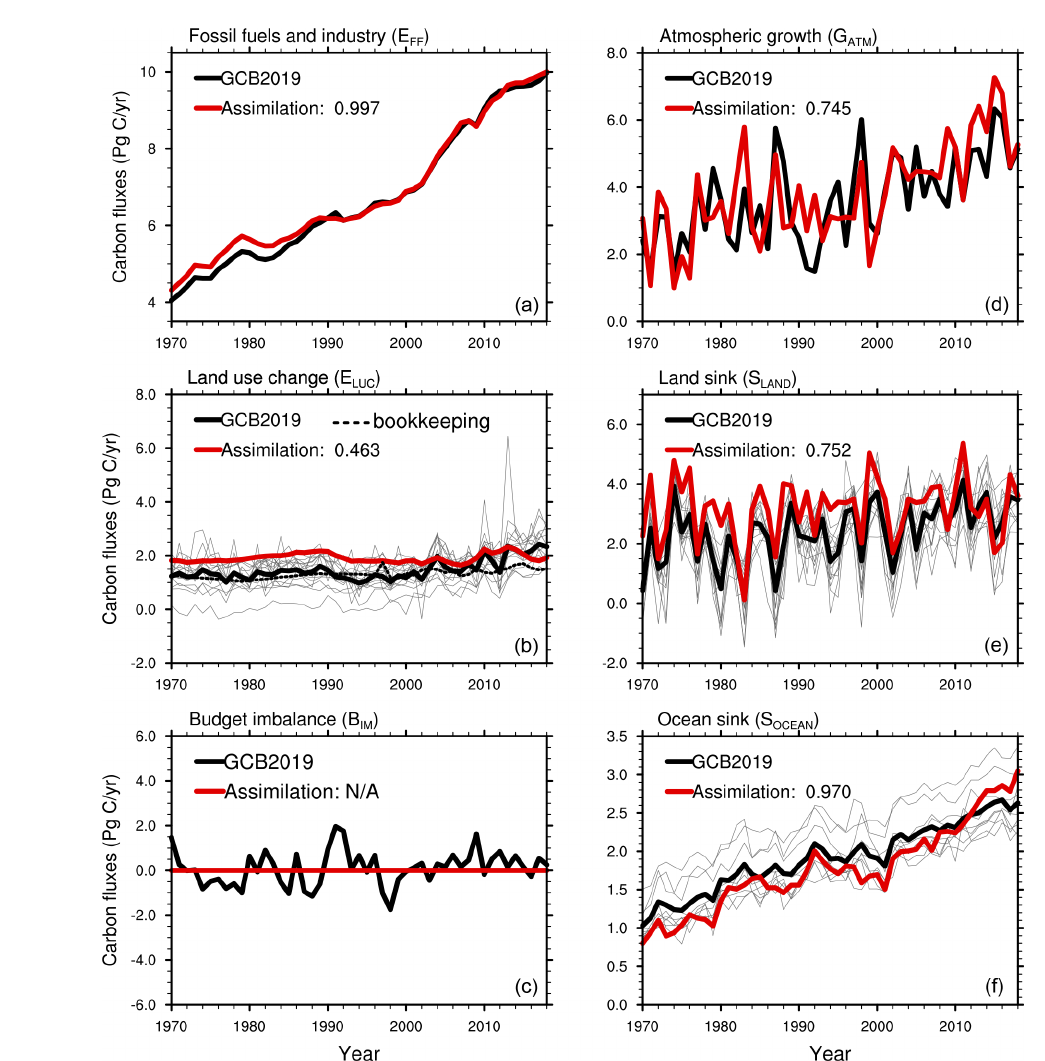
Figure 2. Time series of (a) fossil fuel and industry CO 2 emissions ( E FF ), (b) emissions from land use change ( E LUC ), (c) the budget imbalance ( B IM ) that is not accounted for by the other terms, (d) atmospheric carbon growth rate ( G ATM ), (e) the natural terrestrial carbon fluxes ( S LAND ), and (f) air–sea CO 2 fluxes ( S OCEAN ) from MPI-ESM1.2-LR assimilation in comparison to the Global Carbon Budget (GCB 2019, Friedlingstein et al., 2019). Emissions (a, b) are positive into the atmosphere, while sinks (d, e, f) are positive into their respective compartments. A positive B IM means a higher sum of emissions than sinks. The thin grey curves in (b) , (e) , and (f) show individual GCB standalone model results. The numbers in the legend show the correlation coefficients between carbon fluxes from the assimilation simulation and